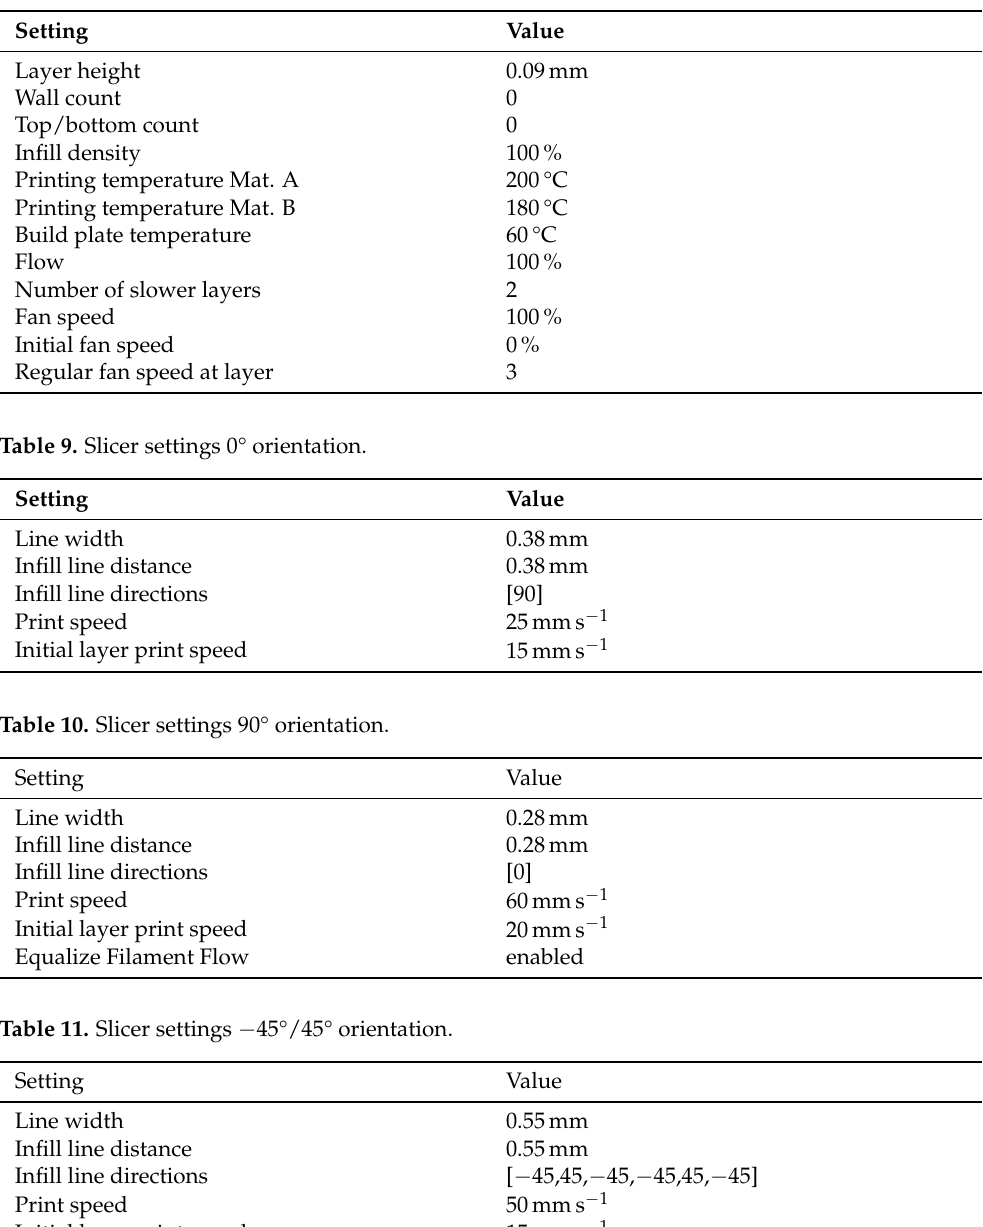
Table 8. Shared slicer settings.